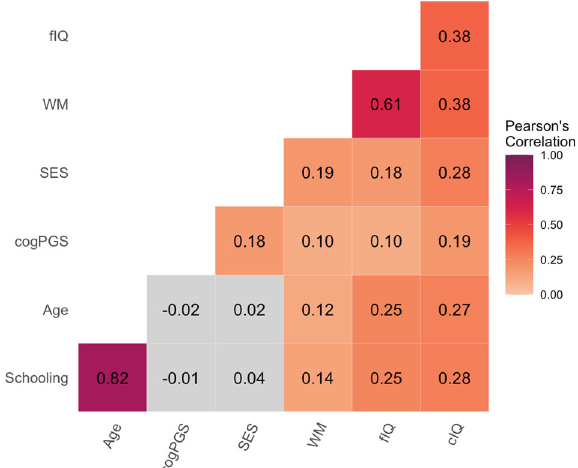
Fig. 1 Corrected correlation plot. A correlation plot showing the relationships of our variables of interest, colored values indicate p < 0.001. These values are corrected for genetic PC ’ s (see Supplementary Fig. 4 for more variables).